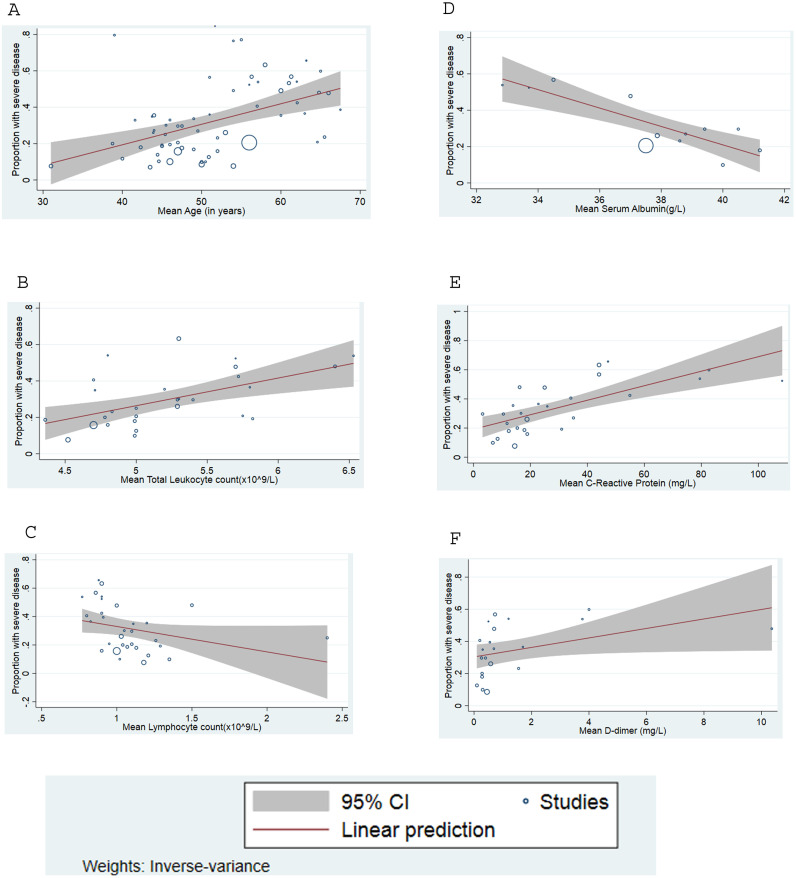
Meta-regression plot shows the proportion increase in severity among COVID-19 patients regressed against (A) mean age. (B) mean leukocyte count. (C) mean lymphocyte count. (D) mean serum albumin. (E) mean C-reactive protein. (F) mean D-dimer.